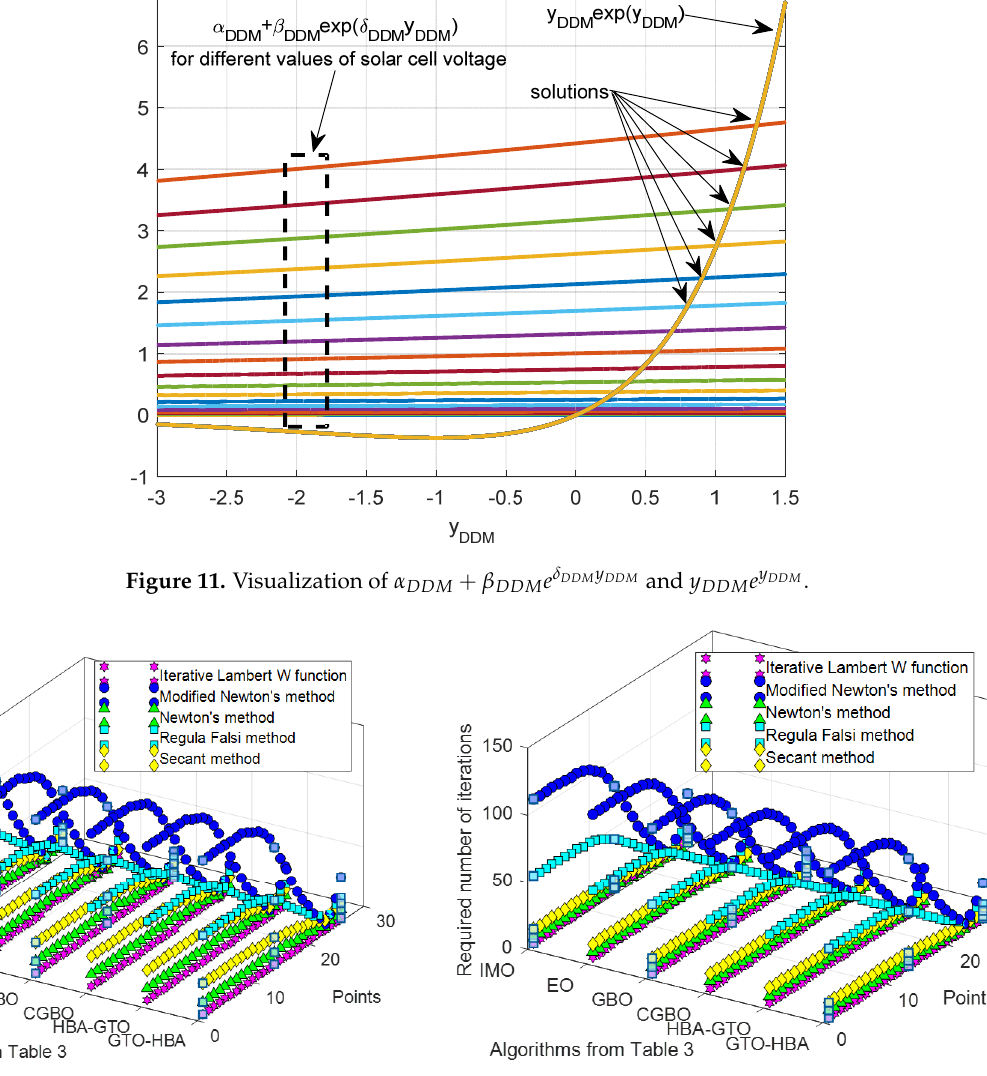
( b ) Figure 10. Convergence curves for NM and the ILWF for all values of the measured voltage: ( a ) Case 1; ( b ) Case 2.